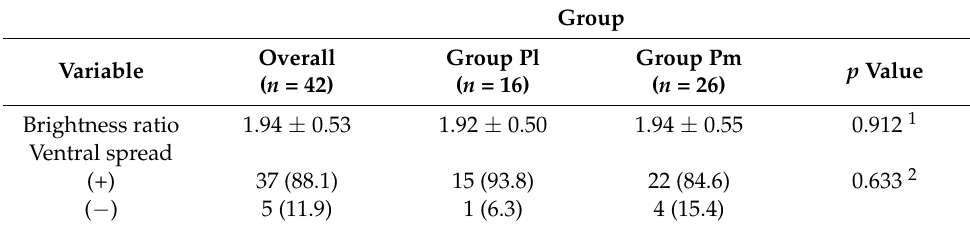
Table 3. Comparison of grayscale brightness ratio and incidence of ventral spread between Group